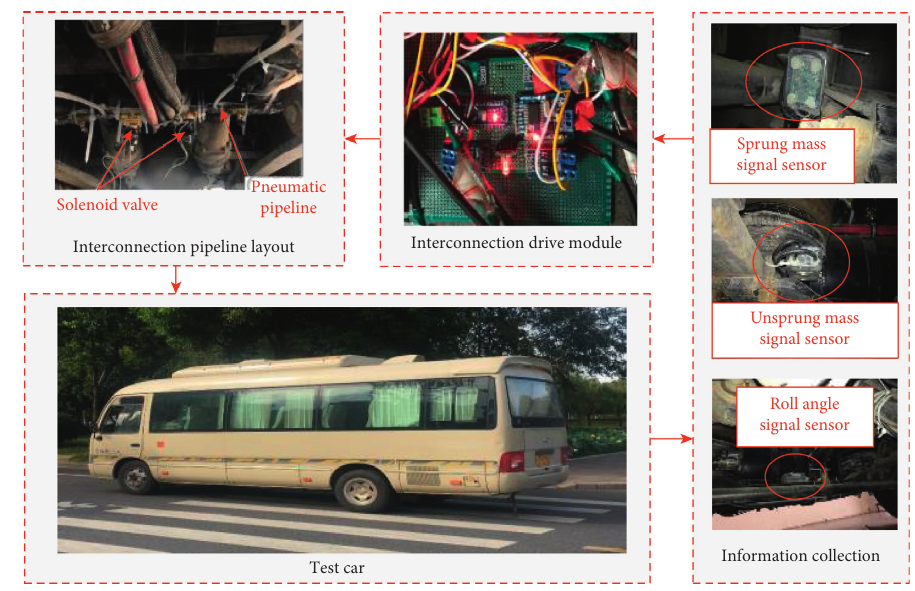
Figure 7: Schematic diagram of the test